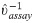
BAGEA, fitted on monocyte eQTL data, selects relevant epigenetic marks and increases directional effect sizes for SNPs close to a TSS.Parameter estimates when applying BAGEA to monocyte eQTL data using as directed annotations histone and DHS ExPecto predictions derived from blood-related cell types (i.e. Blood from Fig 2). (A) For each chromatin assay type, BAGEA models an assay variance modifier
υ^assay-1 that captures the extent to which that assay type is predictive of gene expression. Shown are the square roots for the assay types with the ten highest variance modifiers (from 17 assay types total). In the BAGEA model, DHS, H3K27Ac and H3K4me3 assays have the largest modifiers. (B) For each cell type, BAGEA models a cell type variance modifier
υ^cell-1, similar to the assay variance modifier in panel A. Shown are the square roots for the cell types with the ten highest variance modifiers (out of 61 cell types). In the BAGEA model, CD14 positive cells have the largest modifiers. (C) BAGEA reveals experiments underlying the directed annotations that were most predictive of gene expression. Assay Type x Cell Type: Each experiment is a particular assay type performed in a particular cell type. Effect Size (ω^i, for experiment i): The BAGEA-estimated effect on gene expression. Shown are the ten largest directed annotation effect sizes. In the BAGEA model, the experiments using DHS, H3k27Ac and H3Kme4 with CD14 positive cells have the largest effect sizes. We also see that most of the 253 annotations are estimated to have a close to zero effect. (D) Shown is the estimated distance modifier of the directed component, Fν^. We see a characteristic peak around the TSS, implying that the directed annotations are upweighted close to the TSS.